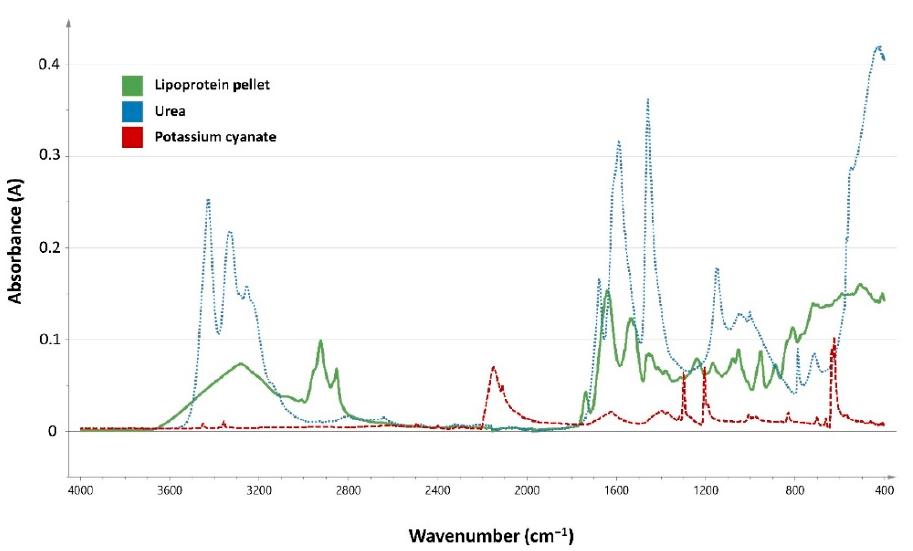
Figure 1. Infrared spectra of precipitated lipoproteins (green), urea (blue) and potassium cyanate (red).